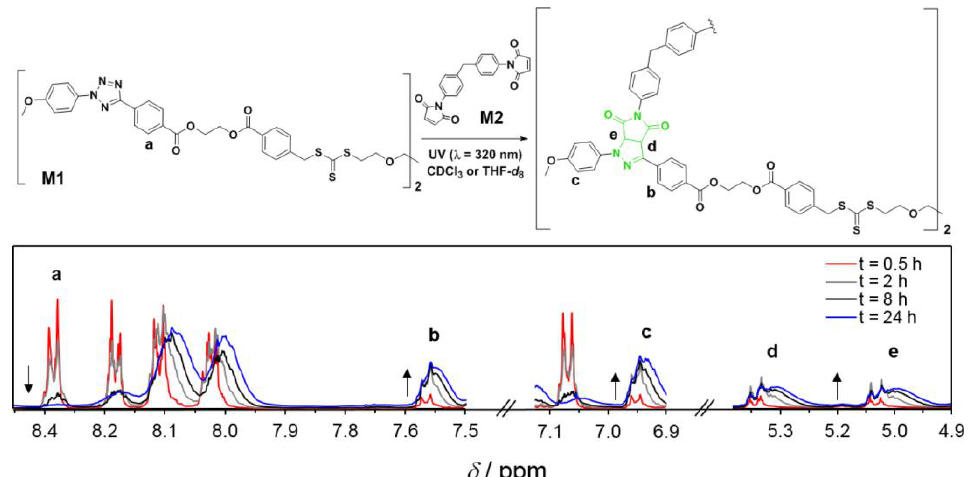
Figure 4. General reaction scheme for the UV-initiated ( λ max = 320 nm) step-growth polymerization of monomers M1 (tetrazole RAFT agent) and M2 (bismaleimide), [M1] 0 = [M2] 0 = 50 mmol L –1 , in CDCl 3 or THF-d 8 . The 1 H NMR spectra (CDCl 3 ) display the evolution of the signals used to determine the monomer conversion and the pyrazoline yield. Reproduced from reference [73].